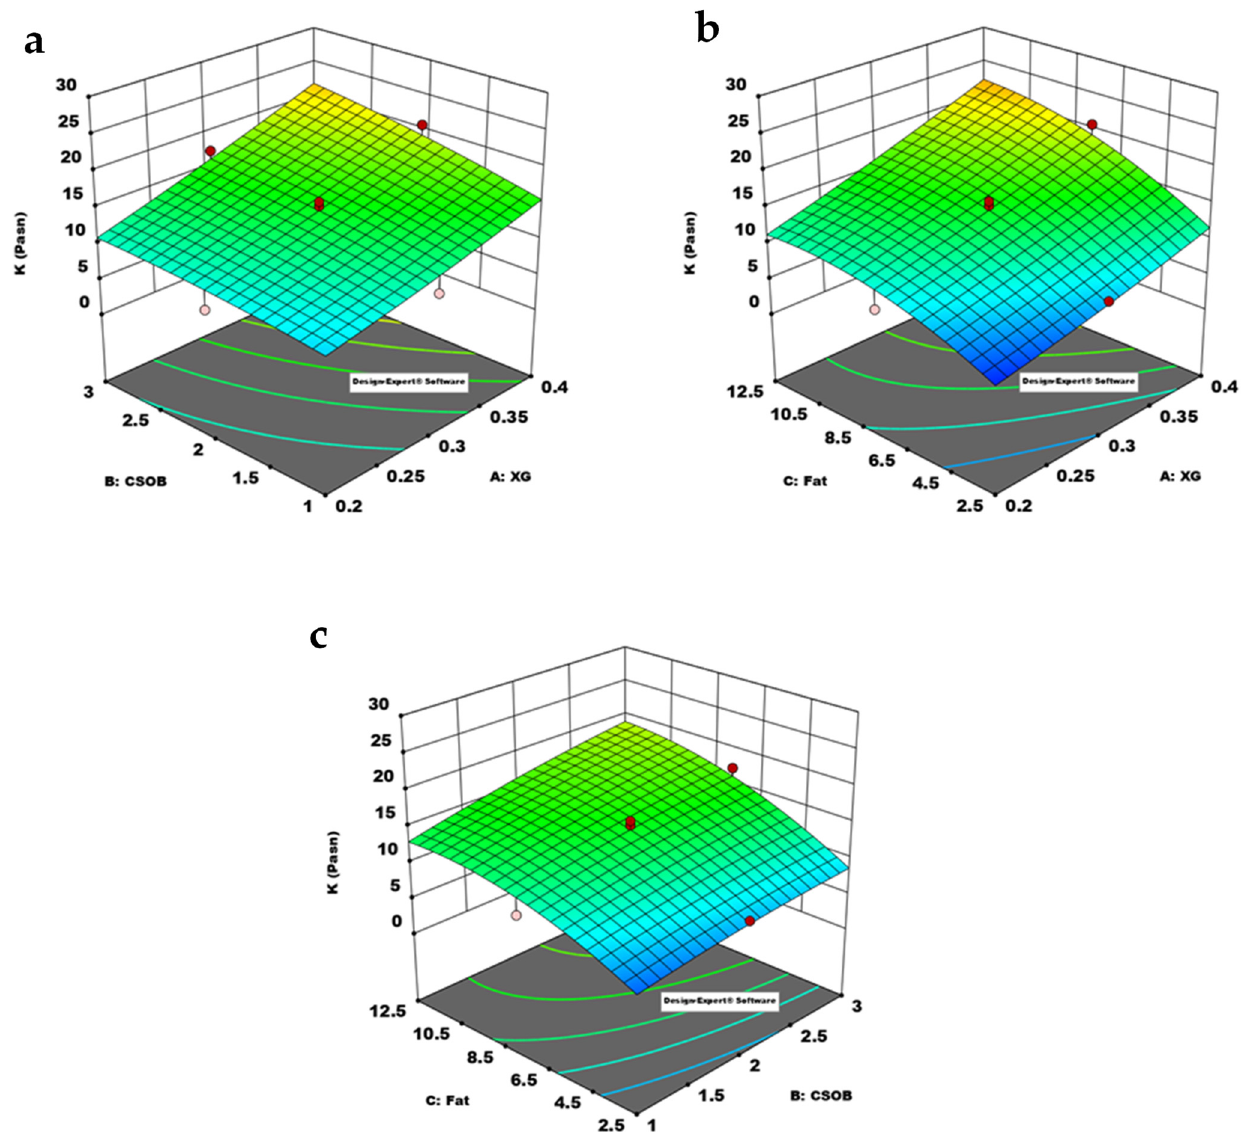
Figure 2. Response surface plot showing the effect of model parameters on the K value of ice cream mixes. ( a ): XG-CSOB, ( b ): XG-Fat, ( c ): CSOB-Fat (A: XG (xanthan gum), B: CSOB (chia seed oil by-product), C: fat (milk fat), K: consistency coefficient).